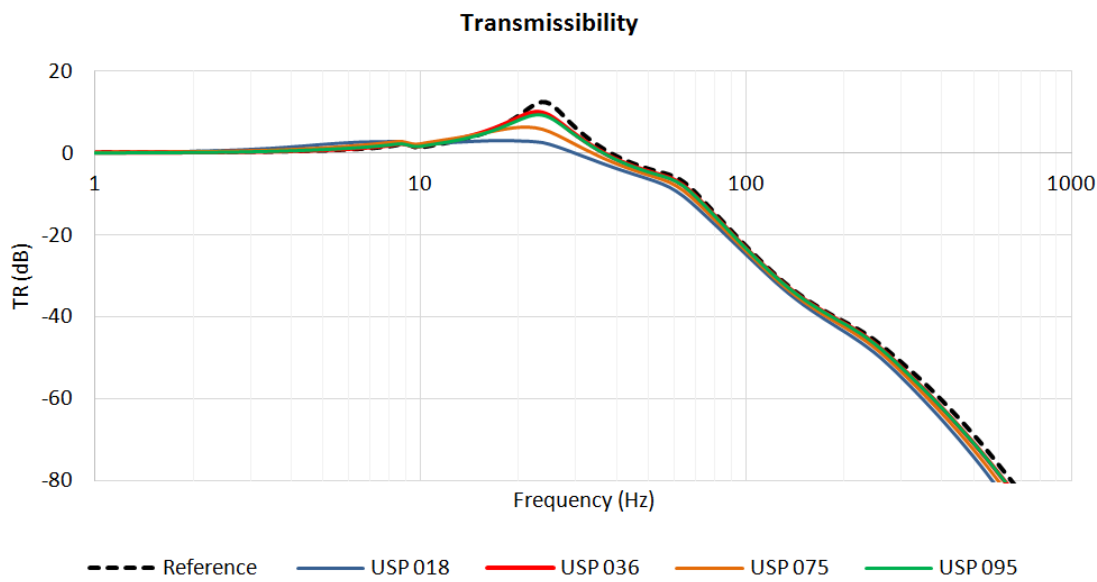
Figure 5. Transmissibility: reference system and systems with four analyzed USP.